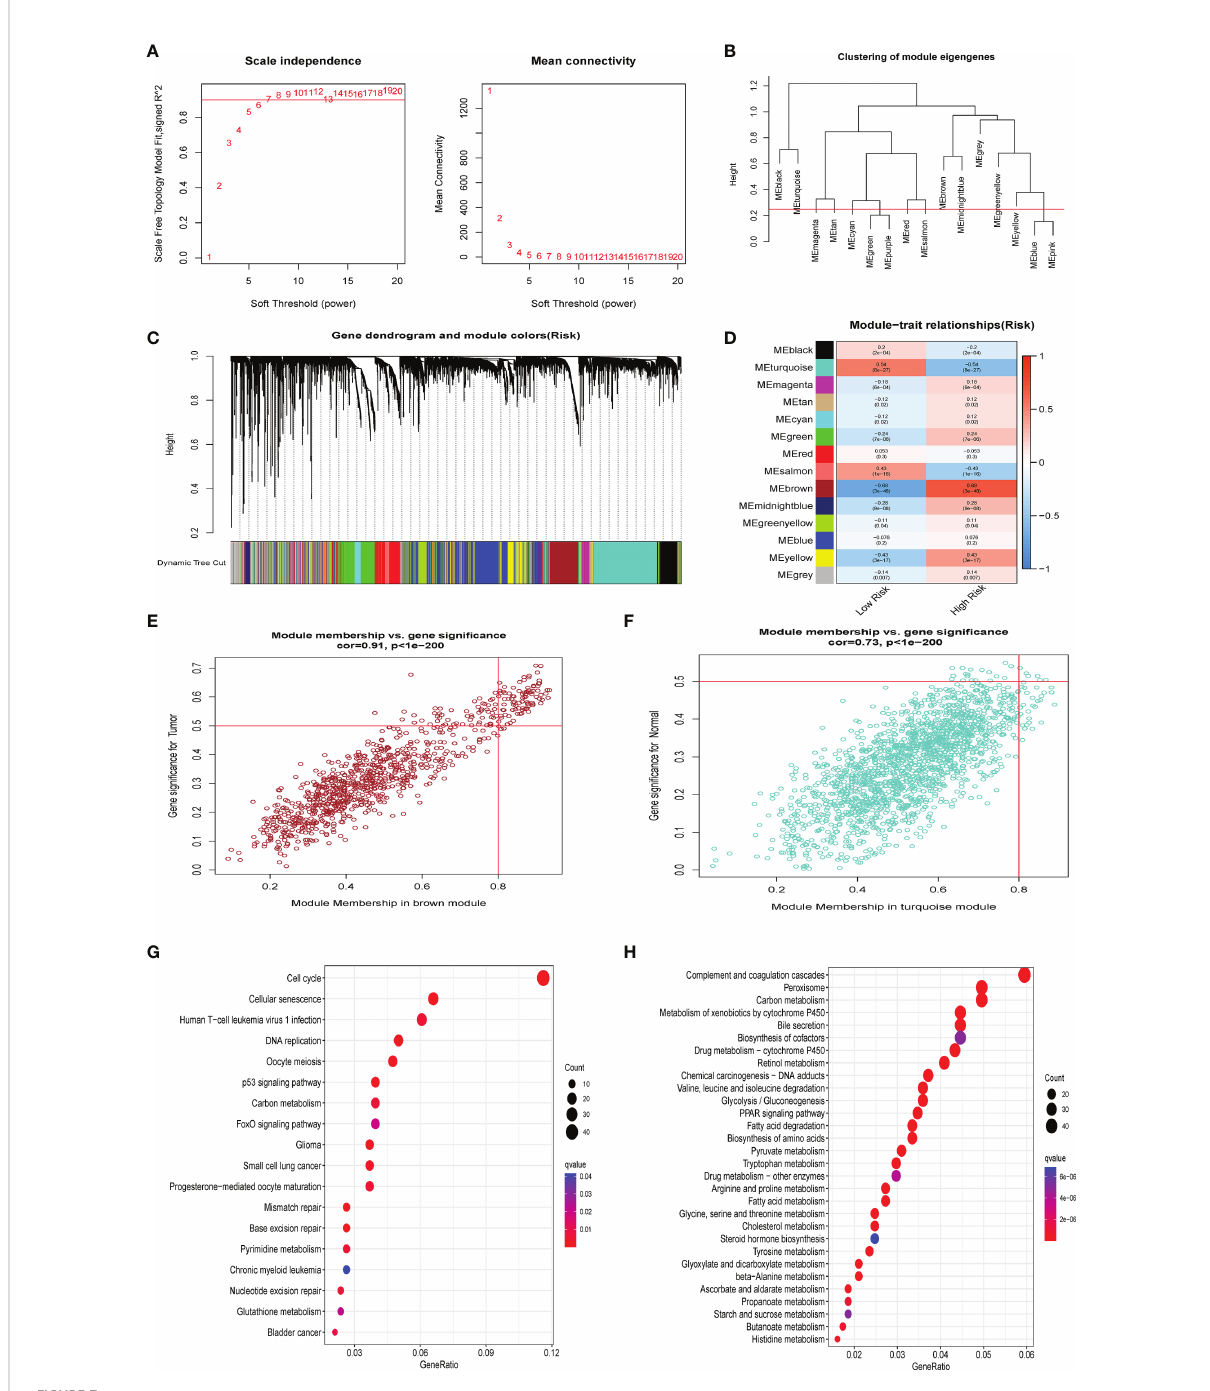
FIGURE 7 WGCNA analysis. (A) The 14 was elected as the soft threshold parameter value to build and fi t the scale-free co-expression network. (B) Clustering of module eigengenes. (C) The branches of the tree diagram correspond to the 14 highly co-expressed gene modules and are color- coded. (D) Correlation coef fi cients and corresponding P-values between each color co-expressed gene module and Risk score are shown in boxes and visualized in different color-block shades. (E) The scatter plot presents the correlation between gene memberships in the brown module. (F) The scatter plot presents the correlation between gene memberships in the turquoise module. (G) The signi fi cant KEGG results of the Brown module. (H) The signi fi cant KEGG results of the Turquoise